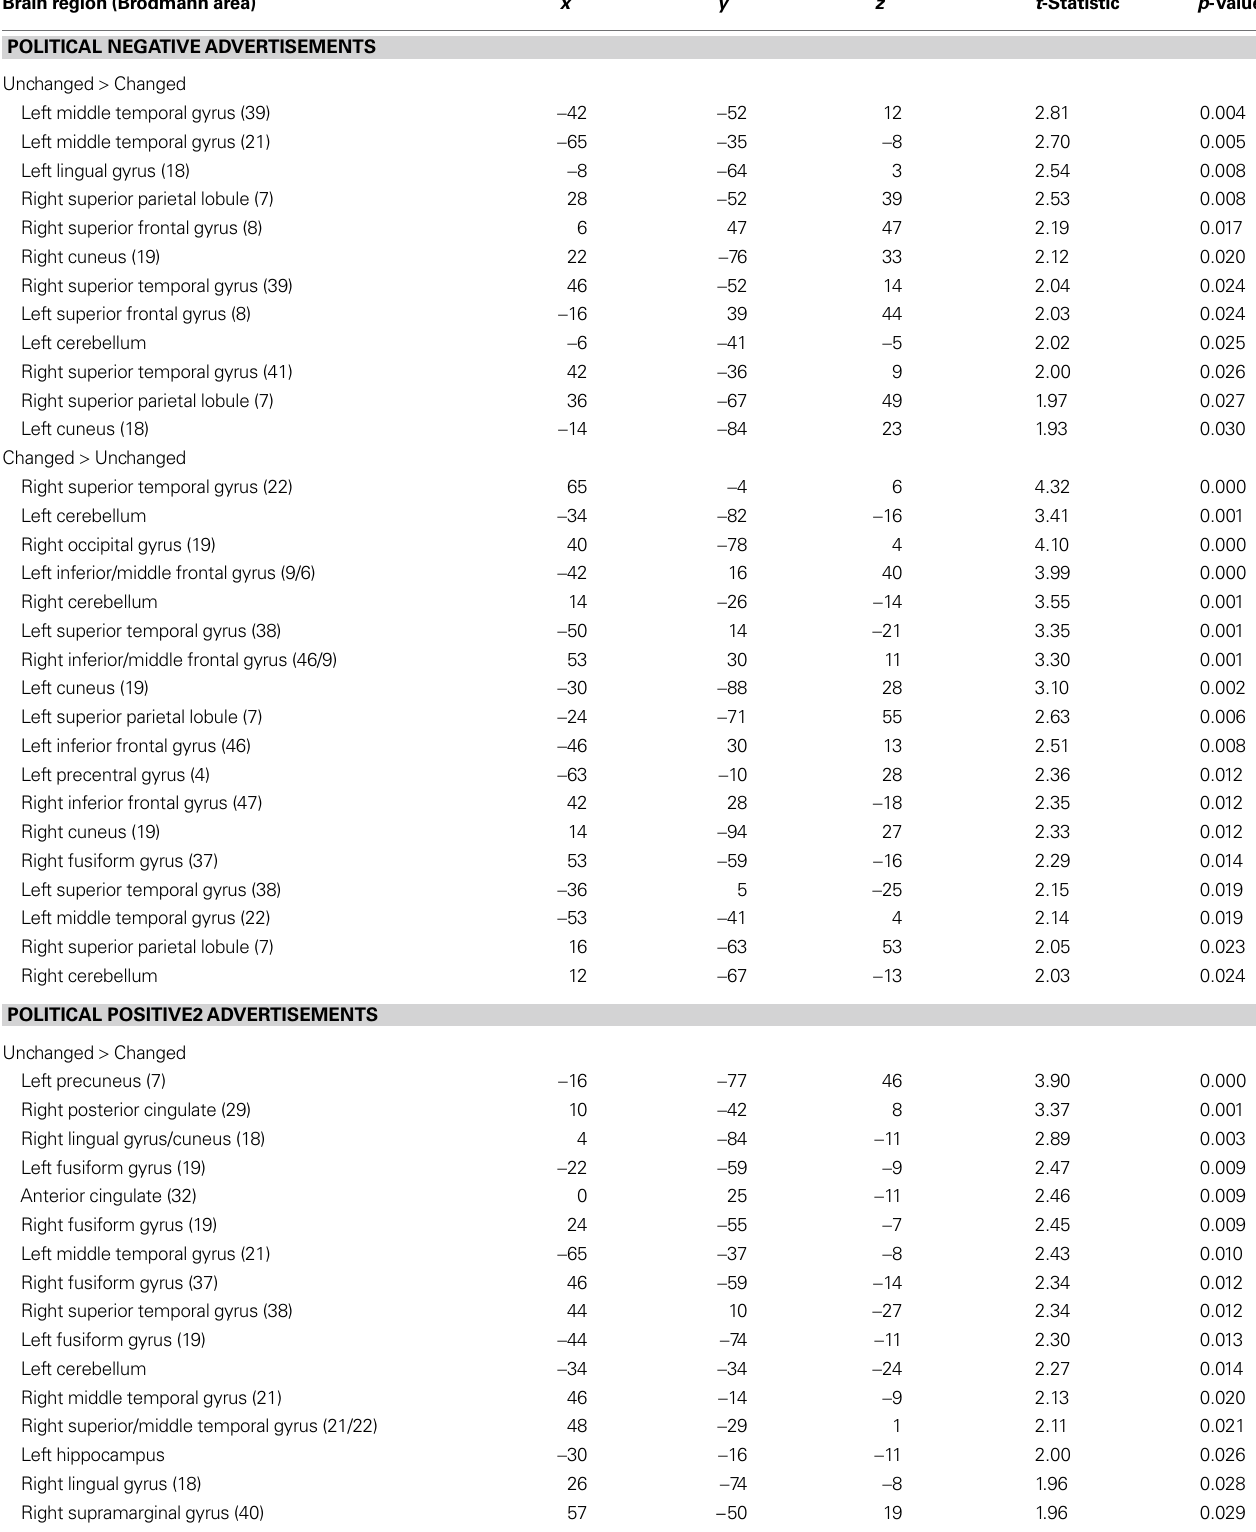
Table 1 | Brain areas detected in the group (random effect) analyses. Brain region (Brodmann